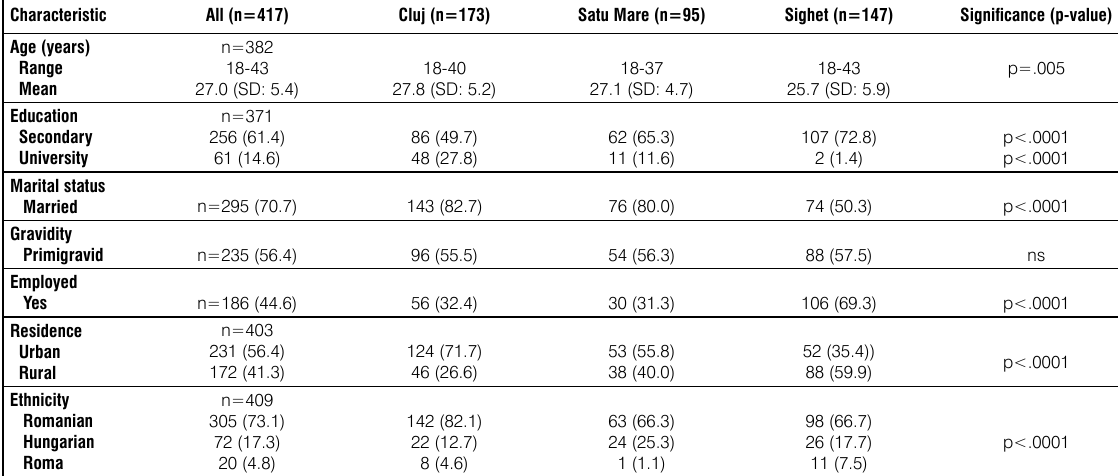
Table 2. Characteristics of study subjects by city.